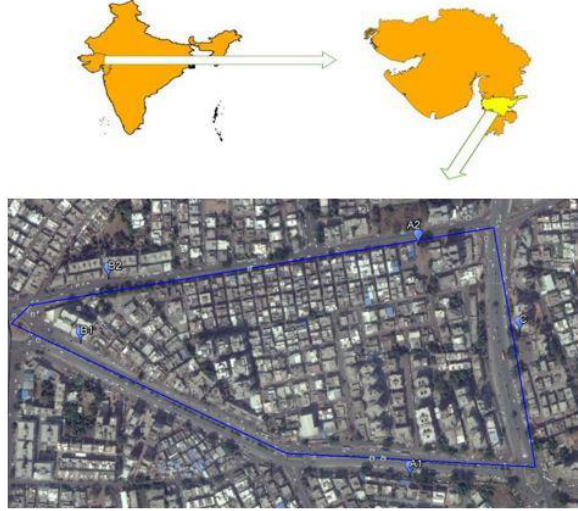
Figure 1: Map of West zone of Surat city showing study area